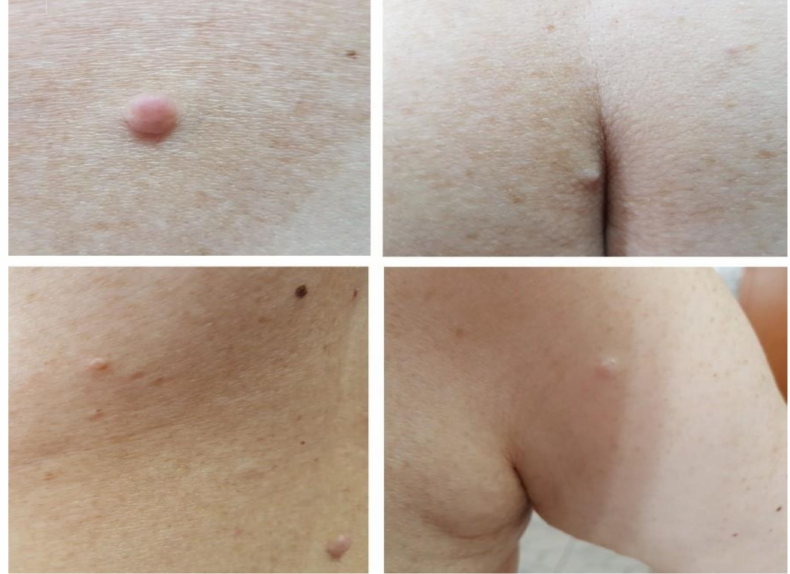
Figure 3. Multiple cutaneous neurofibromas distributed on the trunk and limbs (scale 1:7 / 1:13 / 1:11 / 1:11).